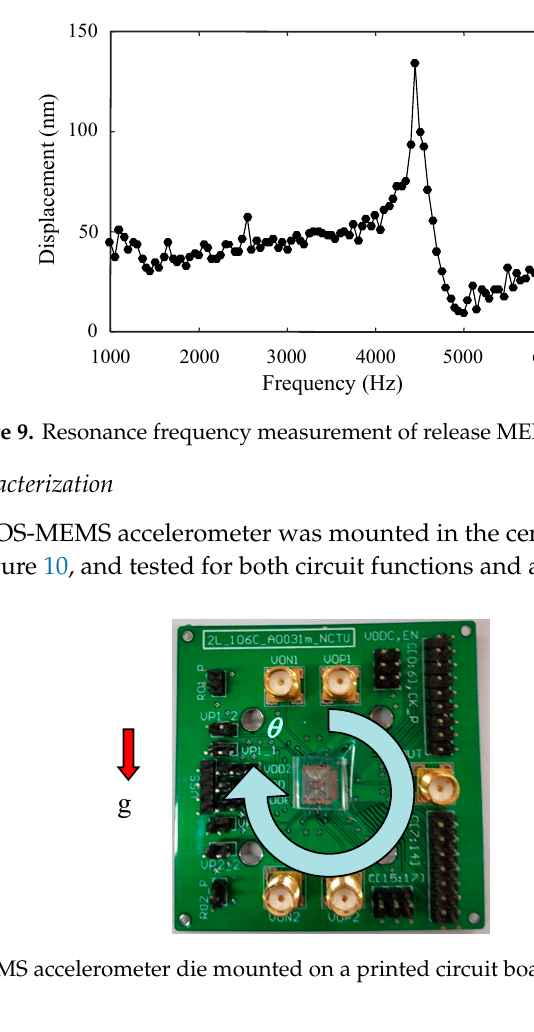
(7) Figure 12. Static acceleration test. 4.2.3. Dynamic Acceleration Test The dynamic acceleration test was performed by mounting the PCB in Figure 10 on an electrodynamic shaker (2007E, The Modal Shop, Inc, Cincinnati, Ohio, U.S.A.). A reference accelerometer (PCB 352C65, PCB Piezotronics, Inc, Depew, New York, U.S.A.) was mounted coaxially to calibrate the vibration levels. The excitation vibration frequency was 50 Hz, and the sensor output was recorded at